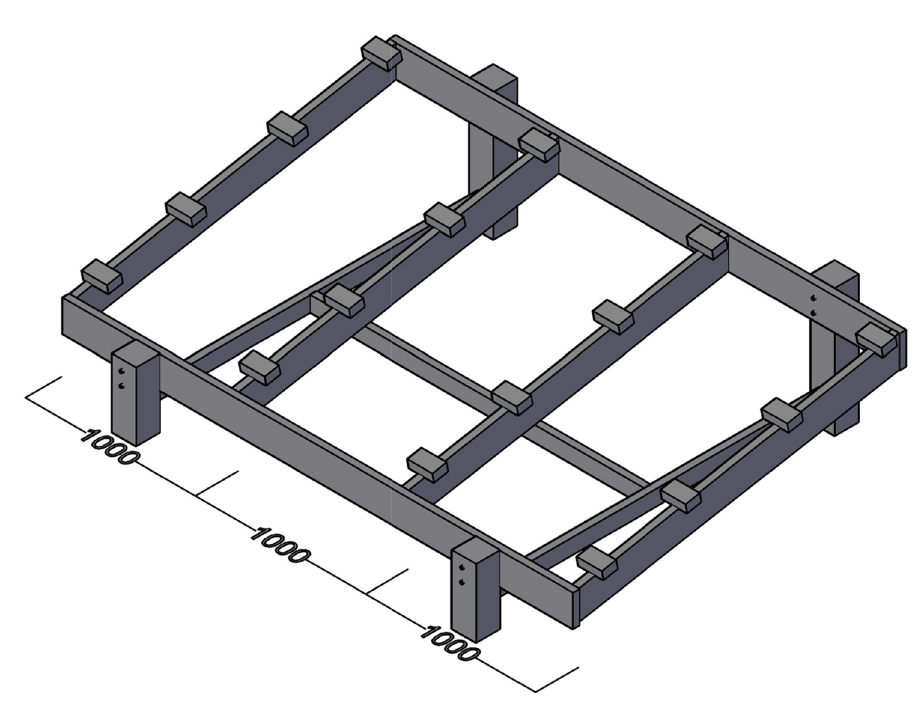
Figure 10. Completed 10-degree fixed rack.